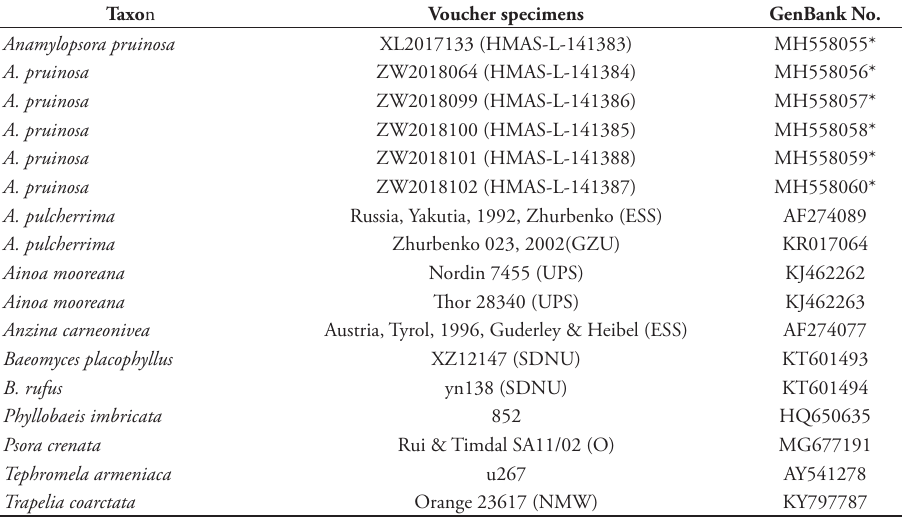
Table 1. Specimens of Anamylopsora from China and taxa used in the phylogenetic analysis in this